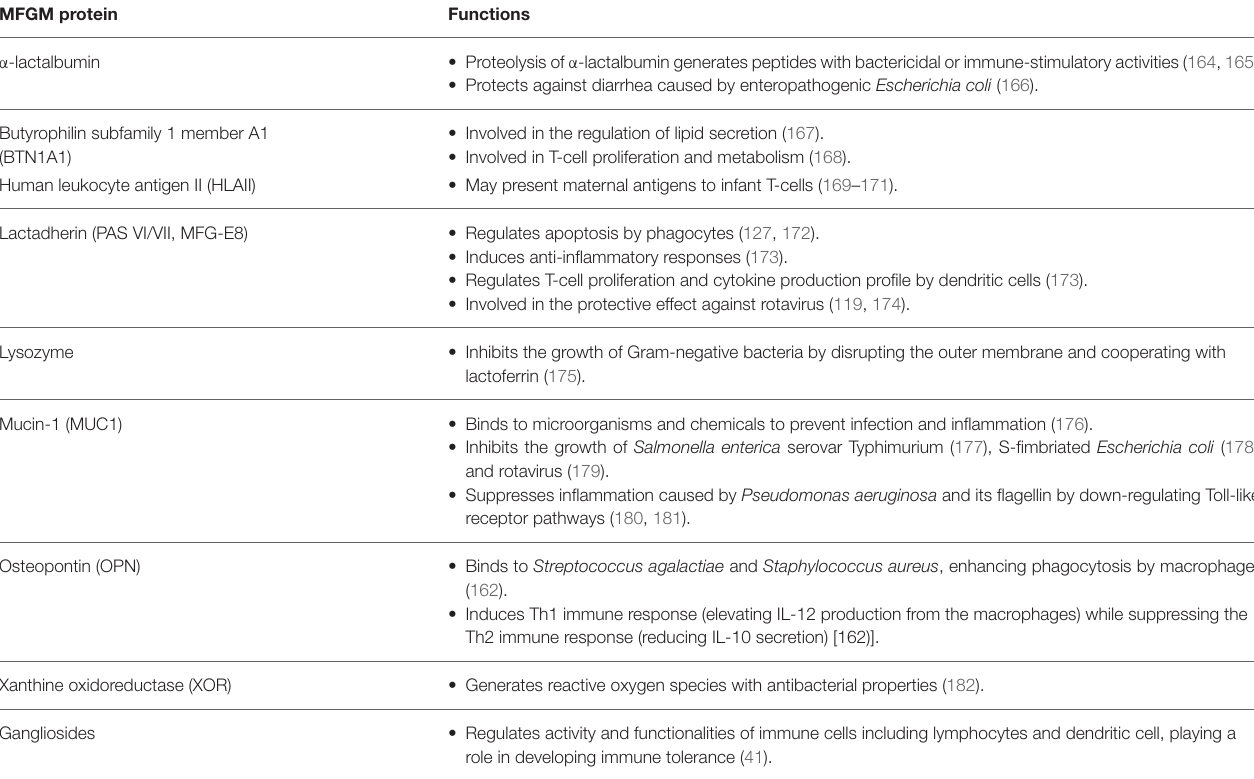
TABLE 4 | MFGM proteins and lipids involved in the infant intestinal immune system. MFGM